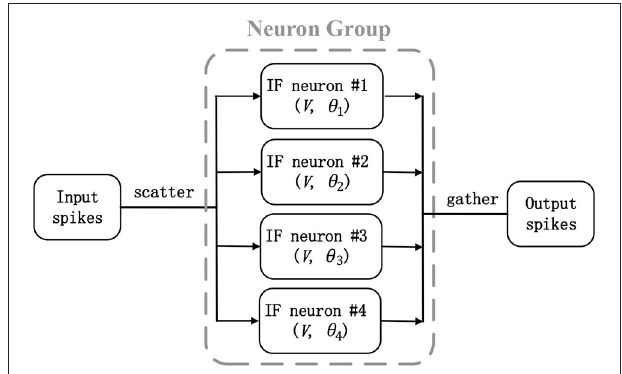
FIGURE 2 | A scatter-and-gather mechanism in artificial neural network (ANN)-to-spiking neural network (SNN) conversion: Four integrate-and-fire (IF) neurons (neuron group) work synchronously and replace an equivalent ANN